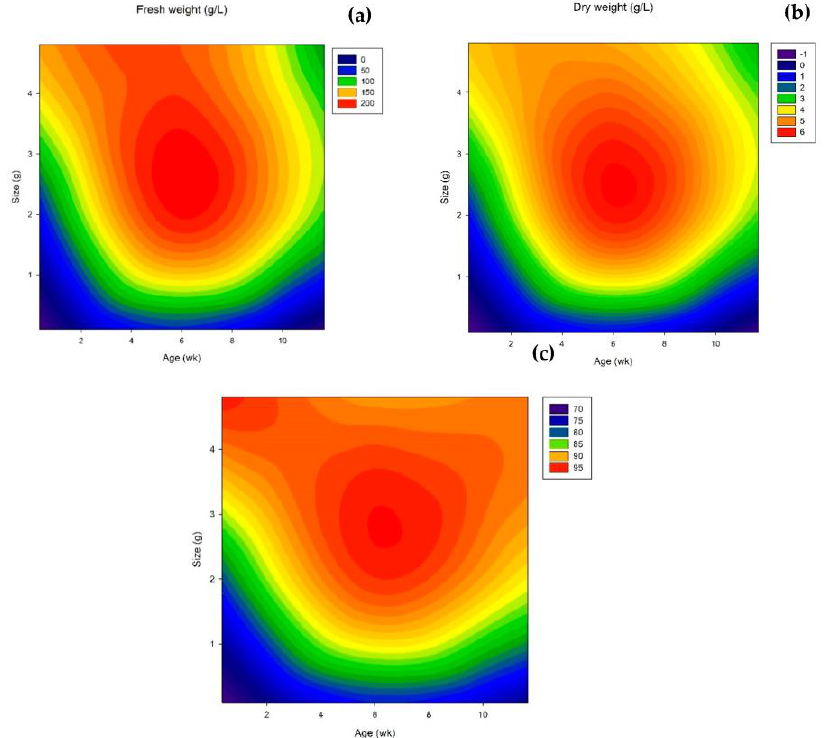
Figure 1. Response surface contour plots showing the interaction effects of inoculum age and size on cell suspension culture on ( a ) Fresh weight, ( b ) dry weight, ( c ) viability of the suspension cultures of T. officinale inoculated with callus at different ages (2- to 10-week-old) and sizes (1% to 40% ( w / v )) (Basal MS medium, sucrose 2.3% ( w / v ), 3.0 mg/L NAA, 3.0 mg/L BAP, 20 ± 2 °C, 115 rpm). The blue color indicates the least optimal values of each variable, while the interaction value approaches the red color, the higher the response variable.